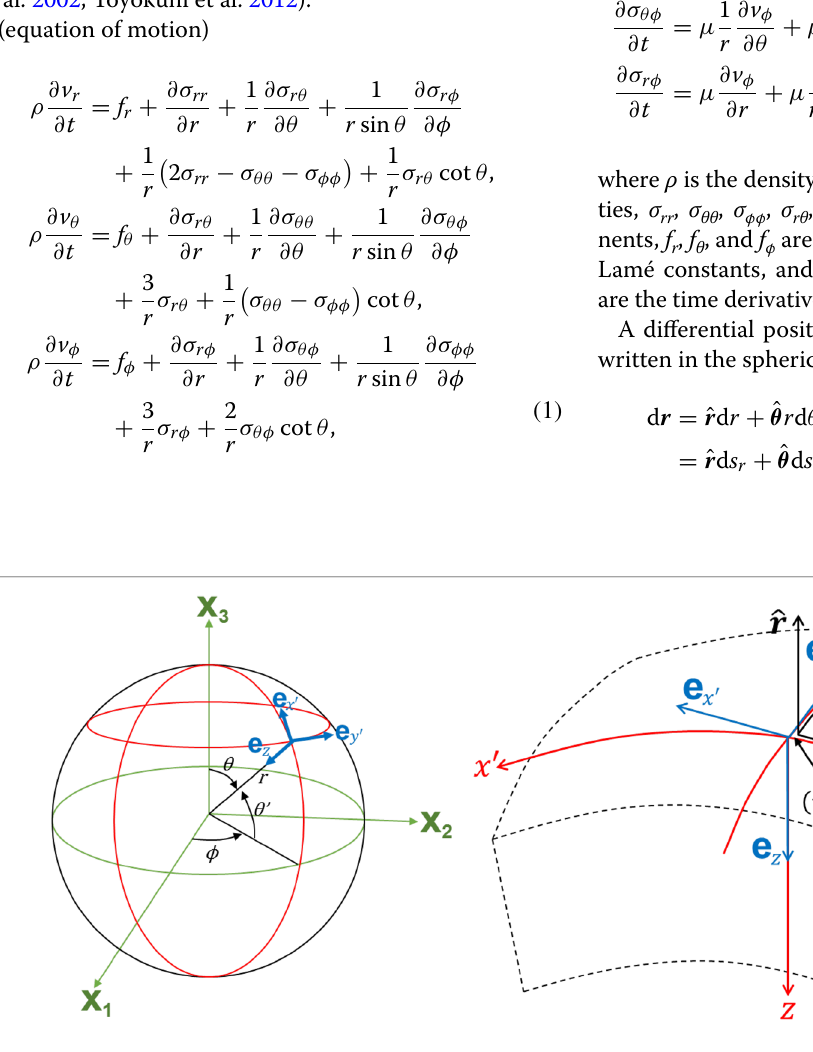
Fig. 2 Relationship between quasi-Cartesian and spherical polar coordinates. Left global view. Right local